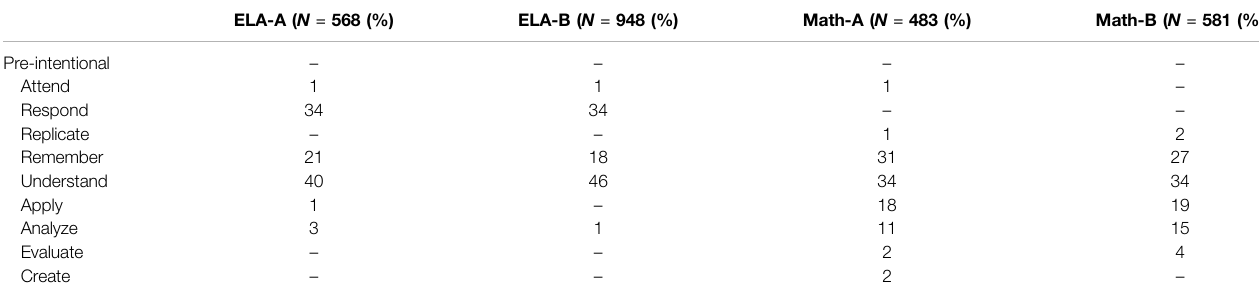
TABLE 5 | Cognitive process dimension for ELA and mathematics